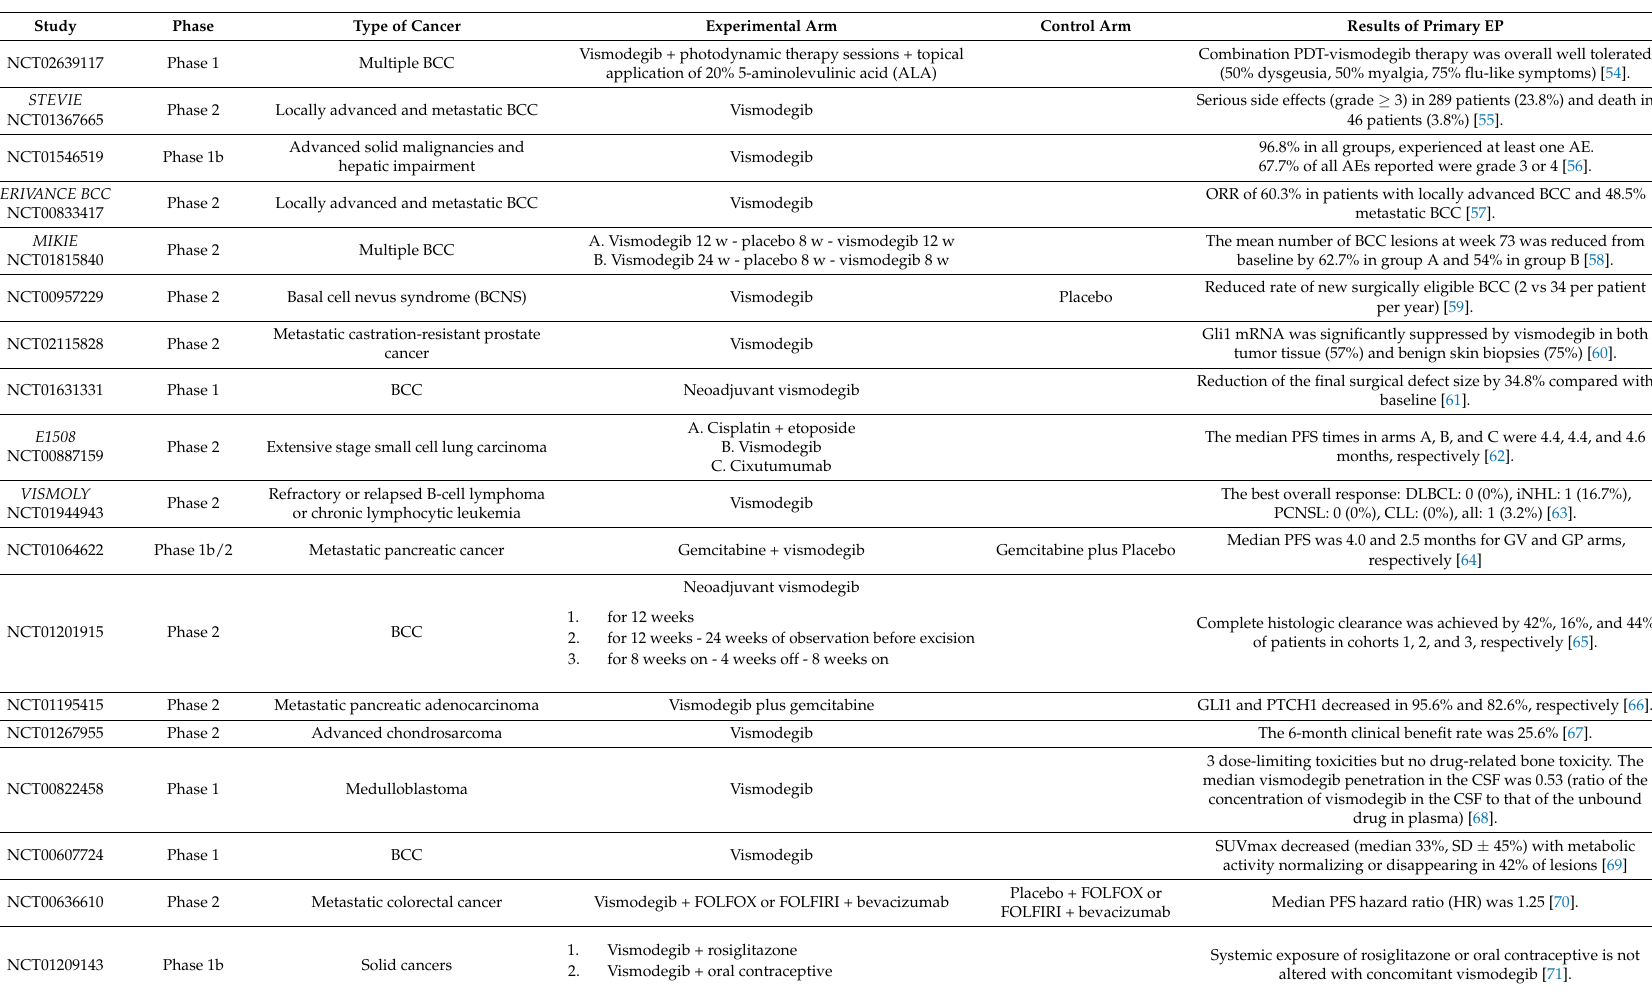
Table 1. SMO inhibitors in malignant tumors tested in clinical trials completed by October